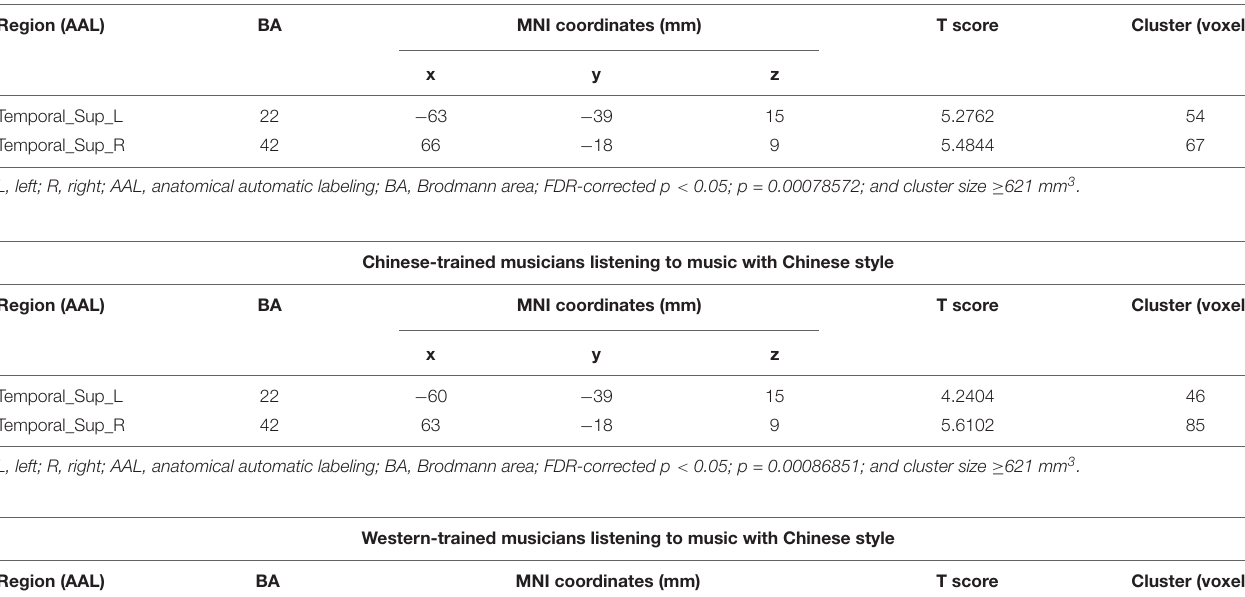
TABLE 2 | Stereotaxic locations of significant clusters of activation. Stereotaxic locations were used to locate significant clusters of activation (Talairach and Pa, 1988). Chinese-trained musicians listening to music with Western